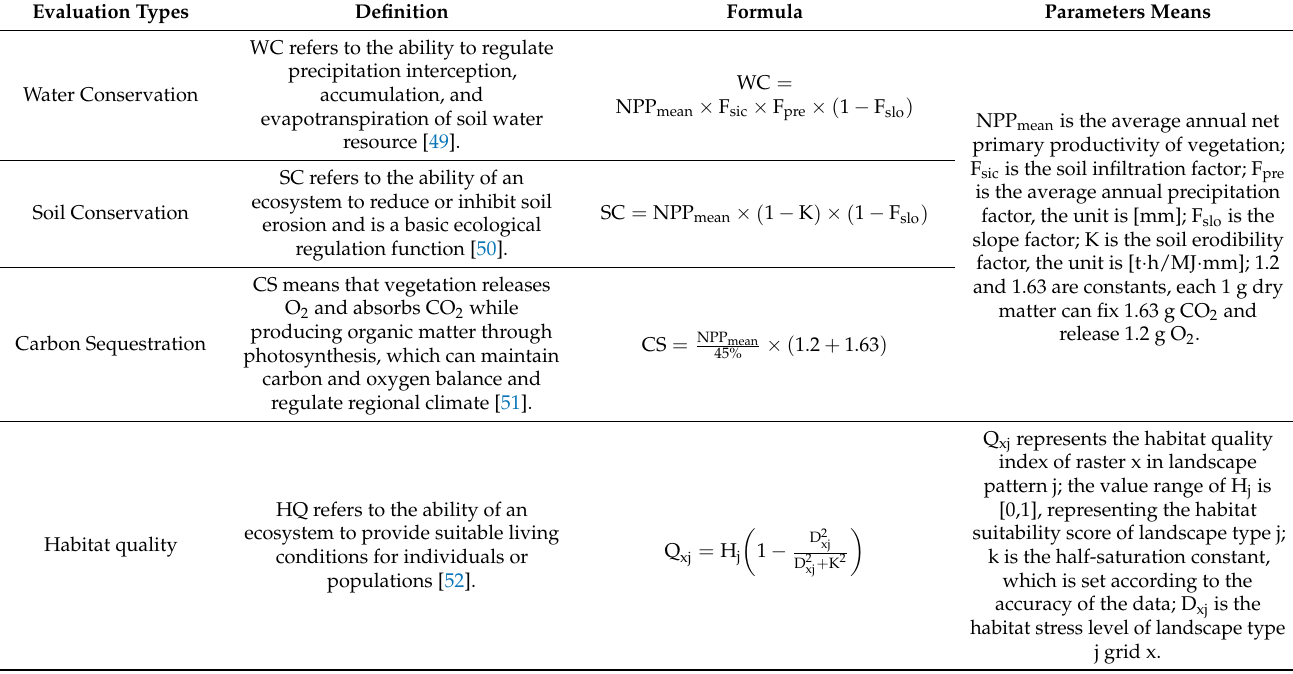
Table 1. The formula of evaluation factors for the importance of ecosystem